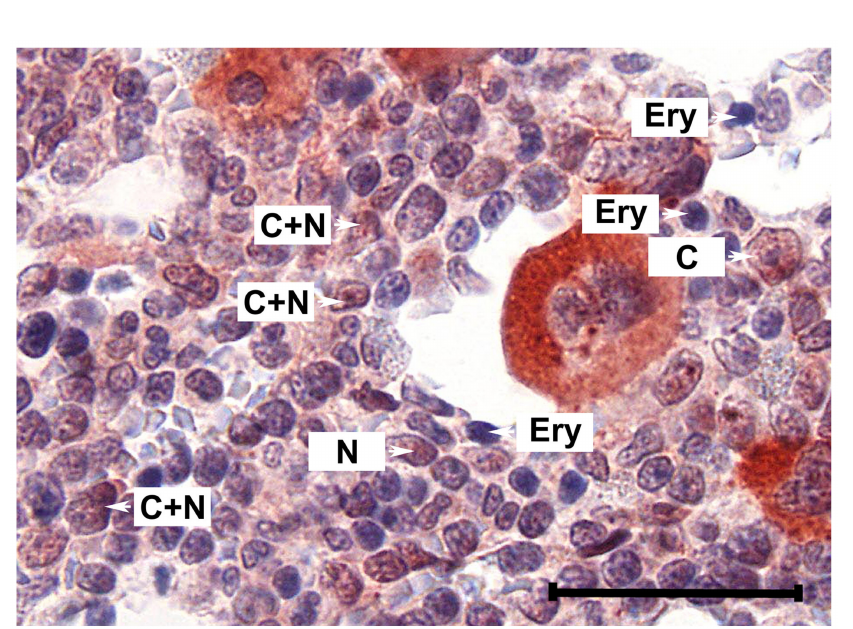
Figure S1: Uncropped Blots of Figure 3C, Figure S2: Uncropped Blots of Figure 4, Figure S3: Uncropped Blots of Figure A3, Figure S4: Uncropped Blots of Figure A5.